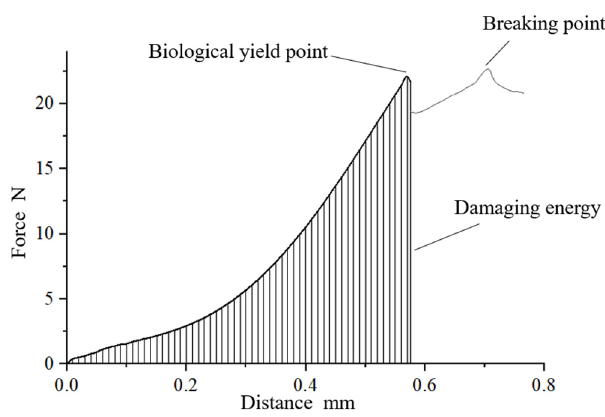
Figure 4. Sorghum seed compression force–distance curve.